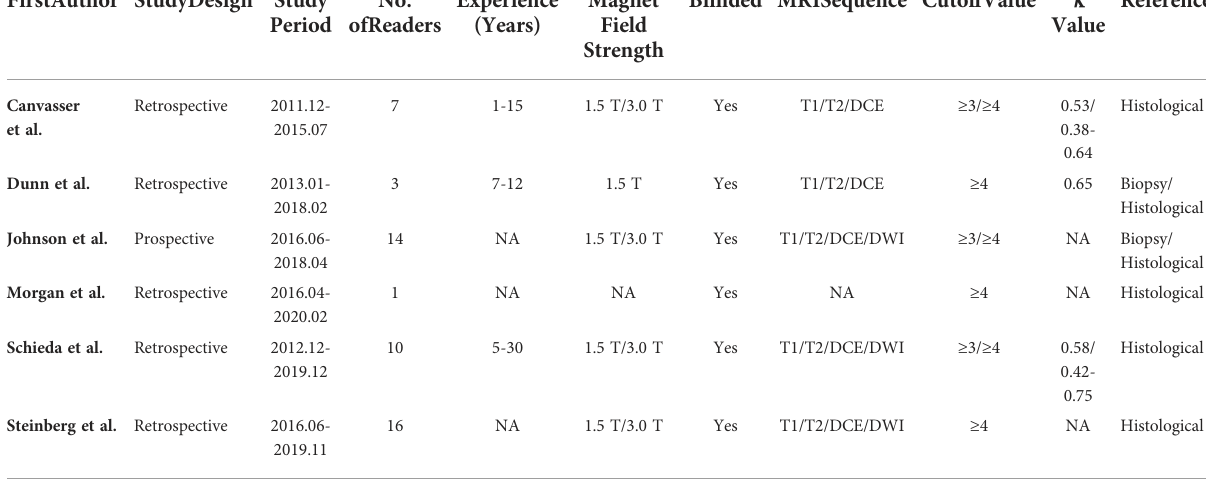
TABLE 2 Study Characteristics of Included Studies.